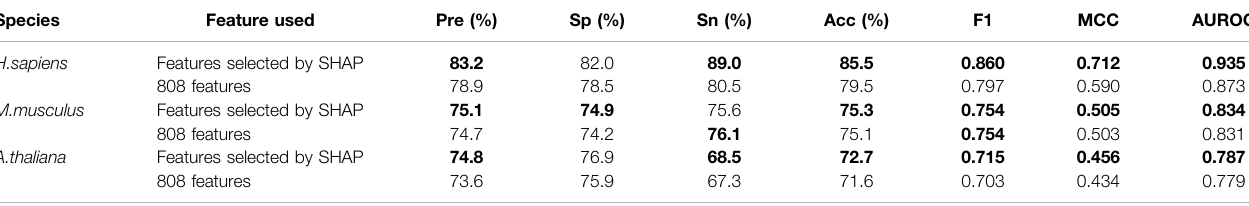
TABLE 5 | The fi ve-fold cross-validation performance of models built based on different classi fi ers with the features selected by SHAP. Species Classi fi ers Pre (%) Sp (%) Sn (%) Acc (%) F1 MCC AUROC H. sapiens RF